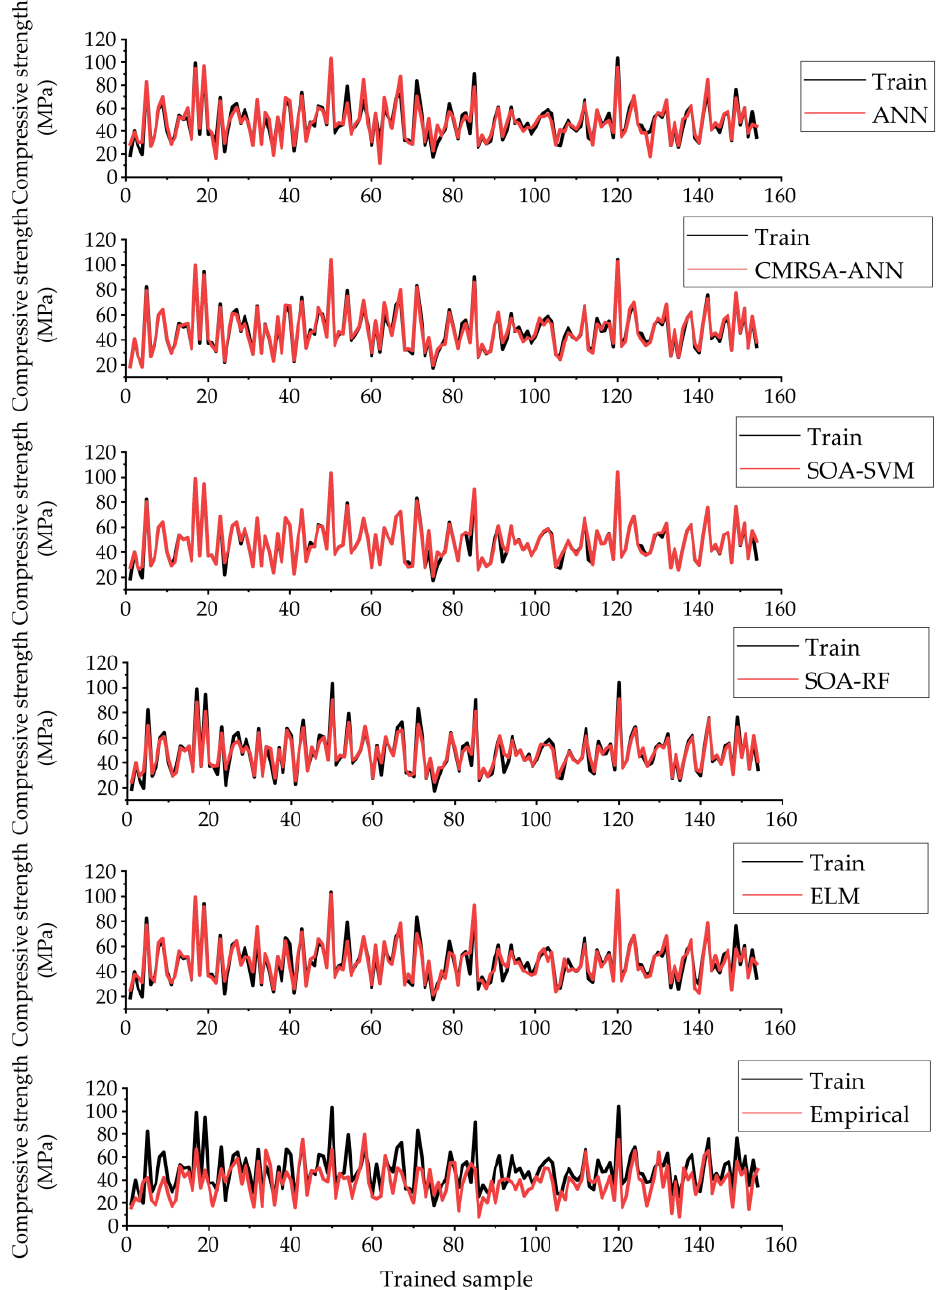
Figure 7. Prediction curves of the developed models using the training set.